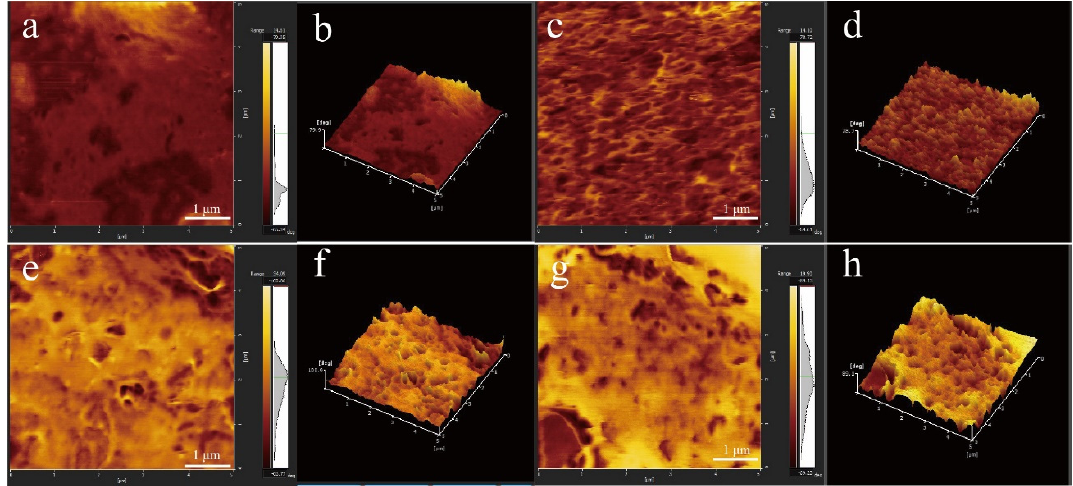
Figure 13. AFM images of cassava starch film and nanocomposite film: ( a ) cassava starch film; ( b ) 3D image of ( a ); ( c ) 3% CNF/ thermoplastic cassava starch (TPS) nanocomposite film; ( d ) 3D image of ( c ); ( e ) 3% Z-CNF/TPS nanocomposite film; ( f ) 3D image of ( e ); ( g ) 3% Z-J-CNF/TPS nanocomposite film;